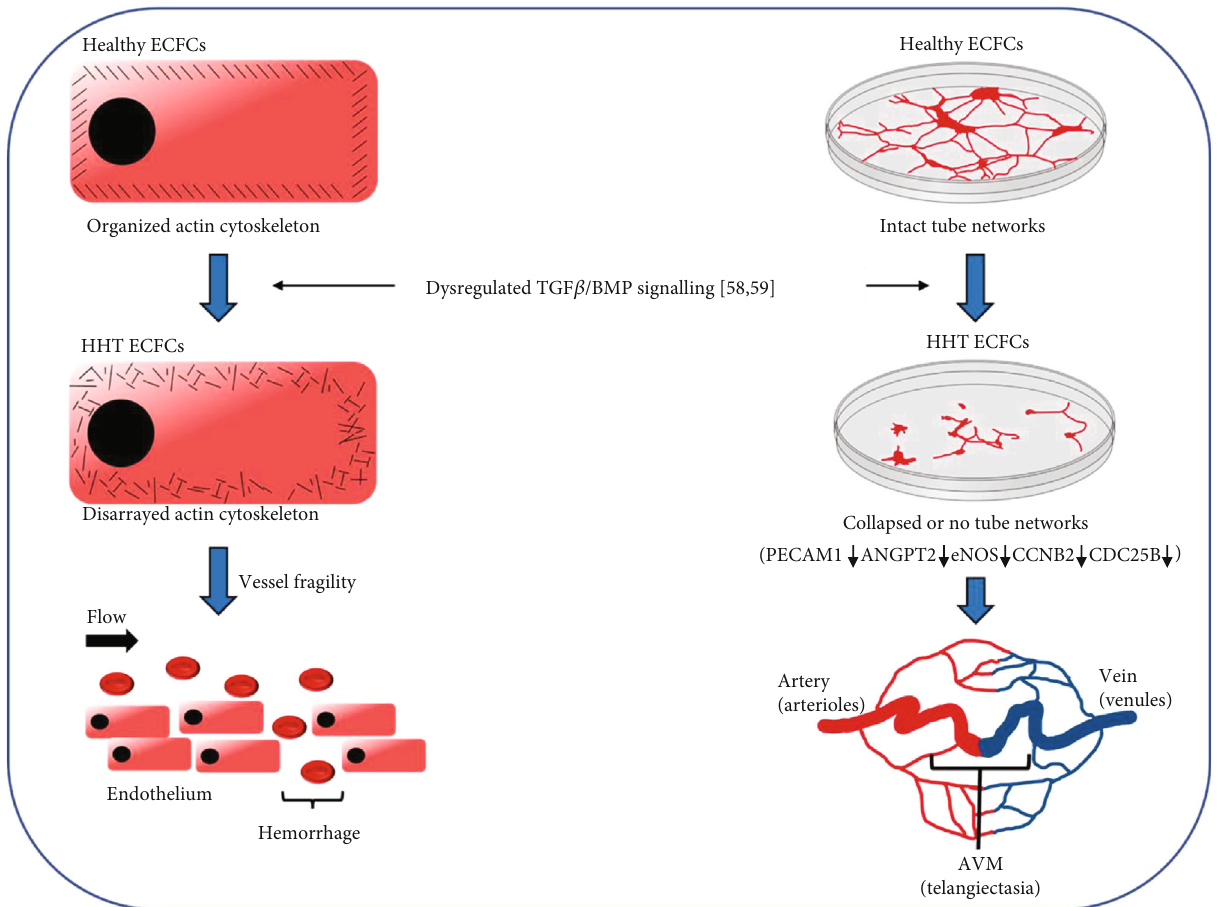
Figure 1: HHT ECFC abnormalities are compatible with clinical manifestations, e.g., epistaxis and vascular lesions, i.e., telangiectasia and AVMs seen in HHT